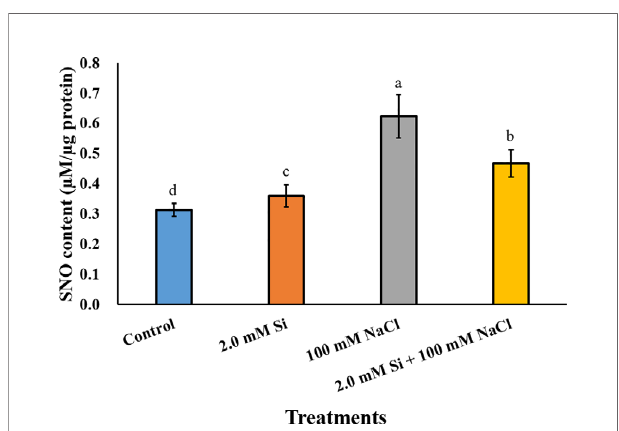
FIGURE 6 | S -nitrosothiol (SNO) content after single or combined Si and NaCl. Data were collected after salt stress for 24 h. Different letters above error bars indicate signi fi cant differences by Duncan's multiple range test ( P < 0.05). Data were collected in triplicate and are presented as the average ± standard error ( n =